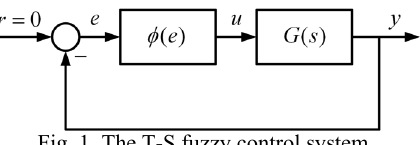
Fig. 1. The T-S fuzzy control